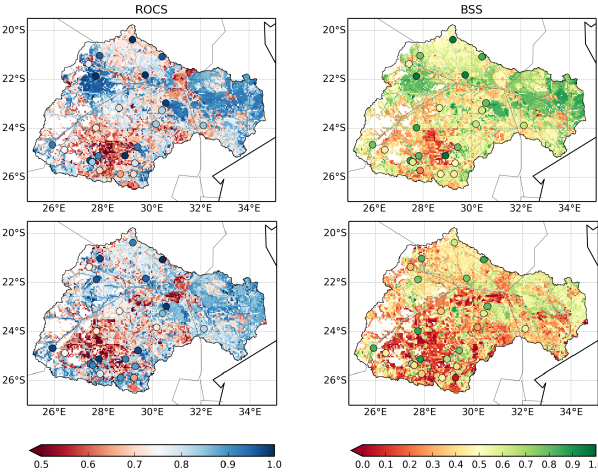
Figure 9. ROCS and BSS for DJFMAM water level (WL) <50th percentile (upper plots), and WL <37.5th percentile (lower plots) for the FS_S4.